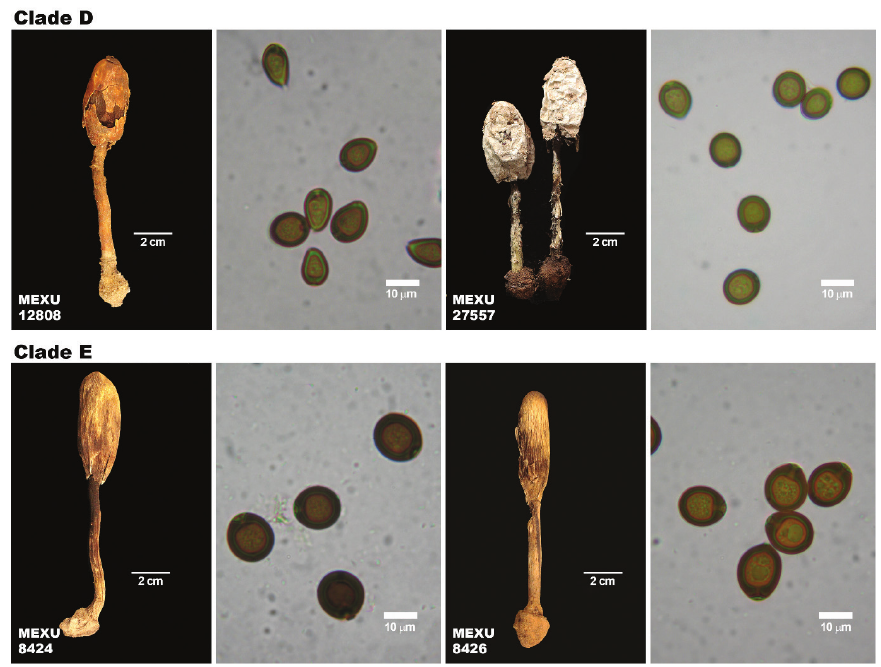
Figure 2. Fruit bodies and basidiospores of selected Podaxis specimens from clades D (MEXU 12808 and 27557) and E (MEXU 8424 and 8426).